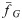
Time series of native tolerance f¯G (green) and migrant tolerance f¯B (blue), by treatment, filtered by extreme values of the native-share initial condition (0.2 ≤ NatShare ≥ 0.7).The error bars (black) show the 95% confidence interval for the mean of the f¯ values across independent simulation runs and the range of Δf that leads to convergence. The dashed line at tmig marks the end of migration waves.